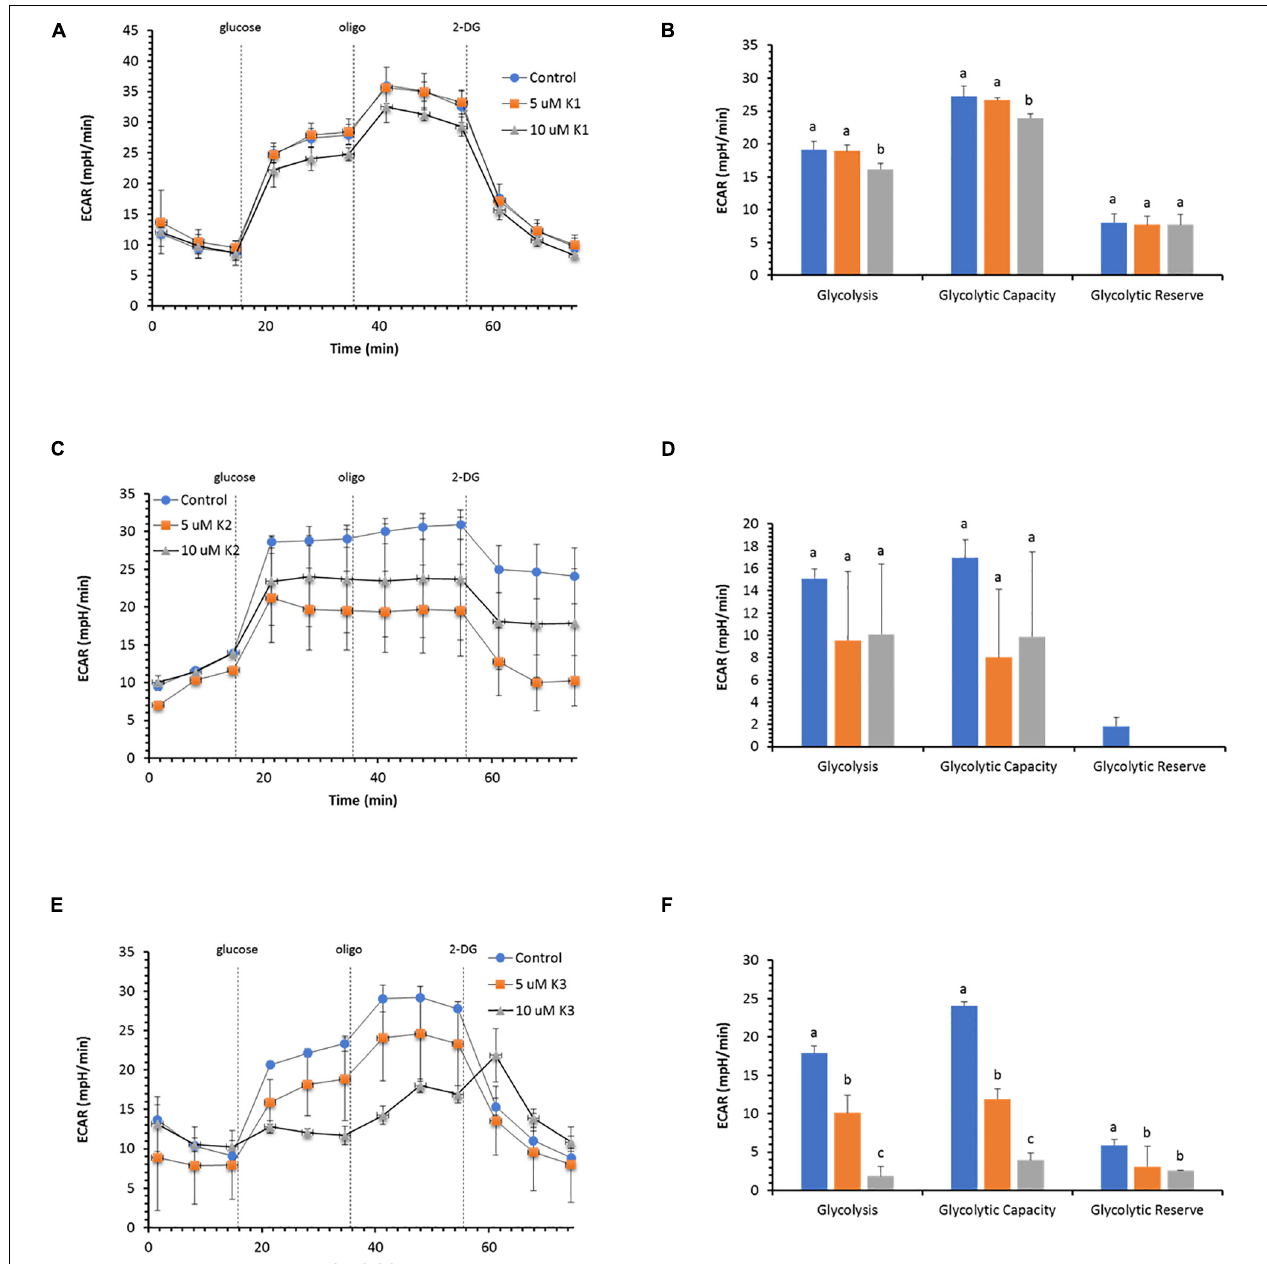
FIGURE 4 | Effect of VKs on the glycolytic function in IPEC-J2 cells. Extracellular acidification rate (ECAR) at two concentrations (5 and 10 µ M) of VK1 (A) , VK2 (C) , and VK3 (E) under basal conditions and after the addition of 10 mM glucose, 5 µ M oligomycin (olig), and 50 mM 2-DG. Injections are shown as dotted lines. The three parameters of the glycolytic function: (glycolysis, glycolytic capacity, and glycolytic reserve) in VK absence (blue) ( (cid:4) ), or in the presence of 5 µ M (orange) ( (cid:4) ), or 10 µ M (gray) ( (cid:4) ) VK1 (B) , VK2 (D) , and VK3 (F) . Data expressed as points (A,C,E) and column chart (B,D,F) represent the mean ± SD (vertical bars) from three experiments carried out on different cell preparations. Different letters indicate significant differences ( P ≤ 0 . 05 ) among treatments within the same